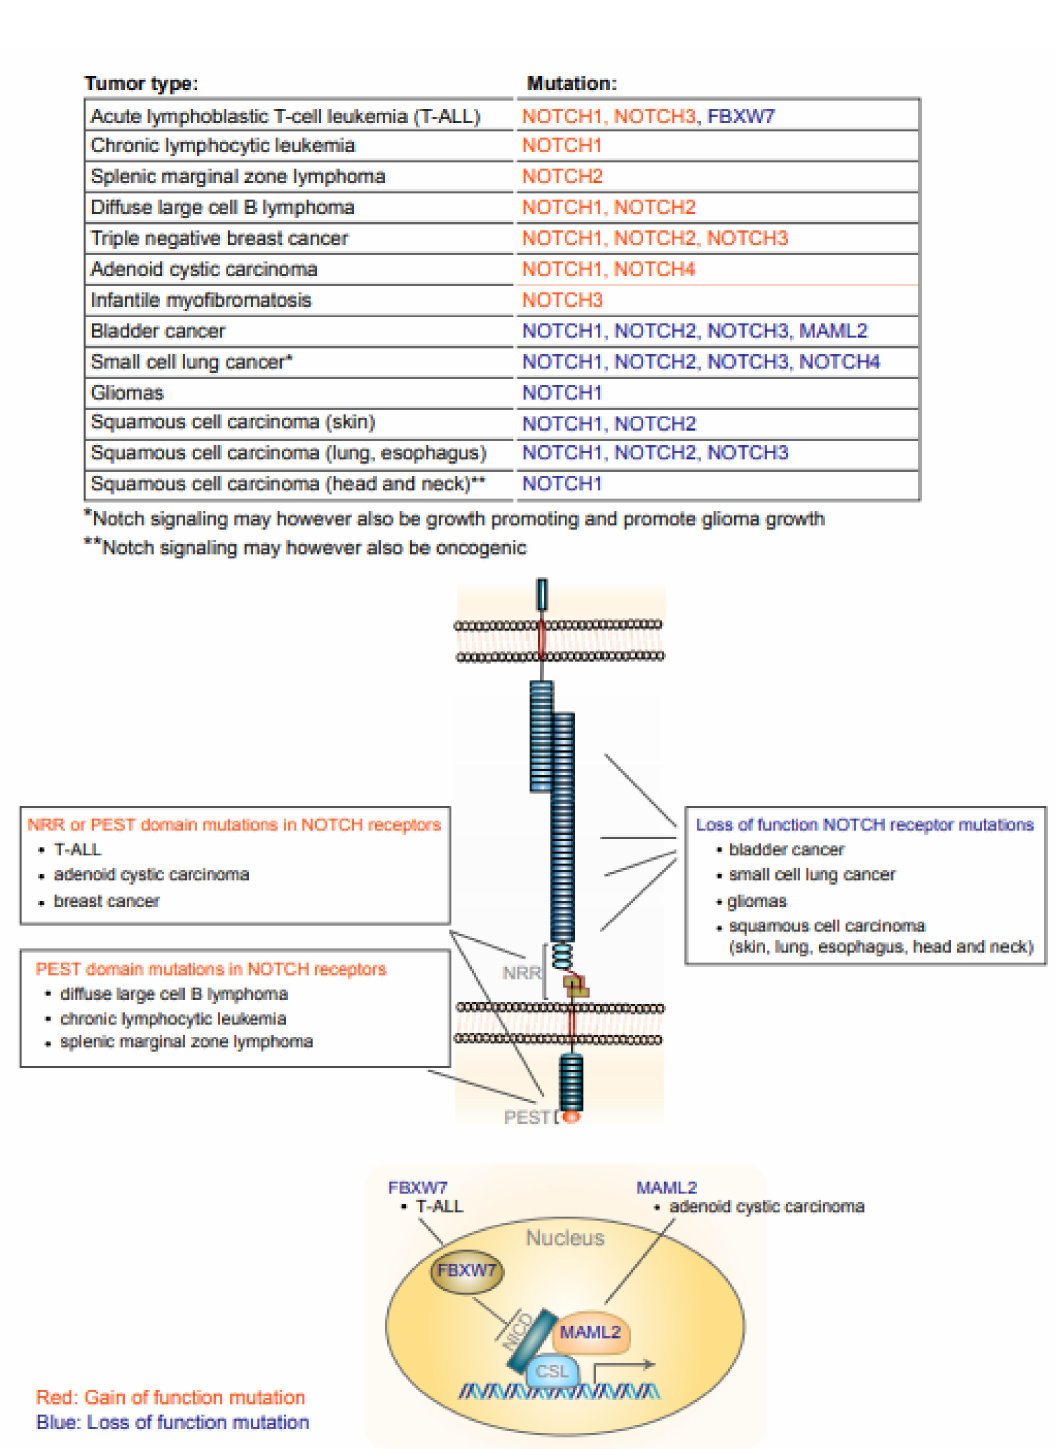
Figure 2. Mutations in genes of the Notch signaling pathway in different types of tumors. At the top of the figure, gain-of-function (blue) and loss-of-function (red) mutations for various types of tumors are shown. Below, a schematic representation of the Notch signaling pathway is shown, with the locations of the gain- and loss-of-function Notch mutations in the Notch receptor depicted, along with mutations in the MAML and FBXW7